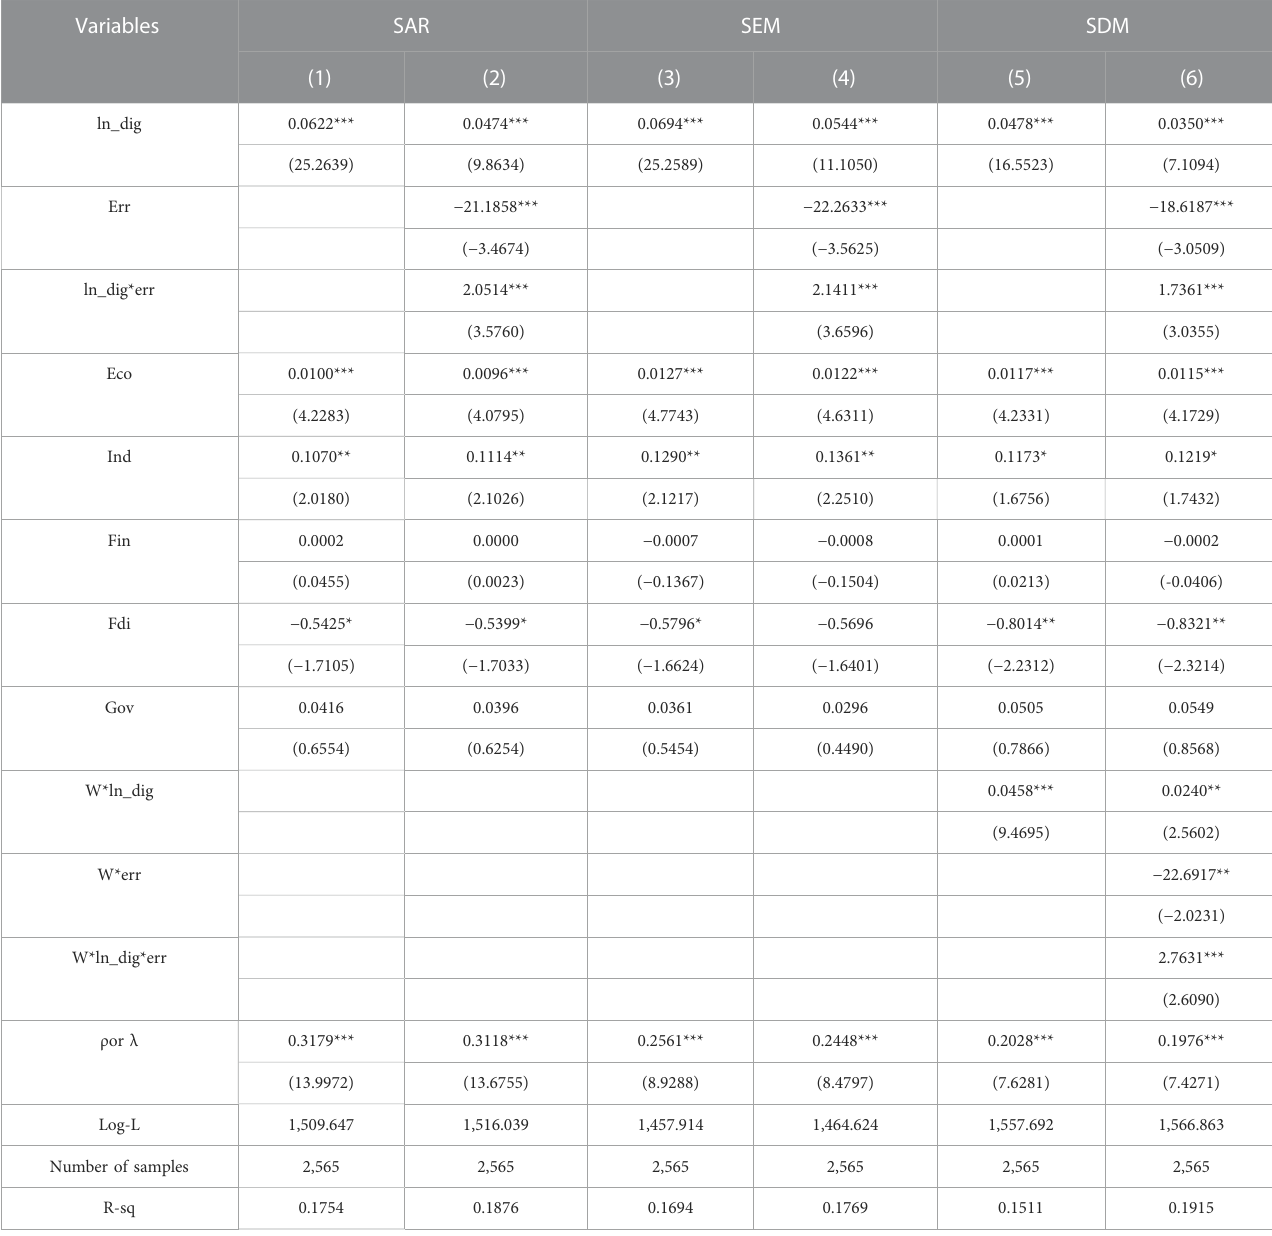
TABLE 6 Spatial econometric regression